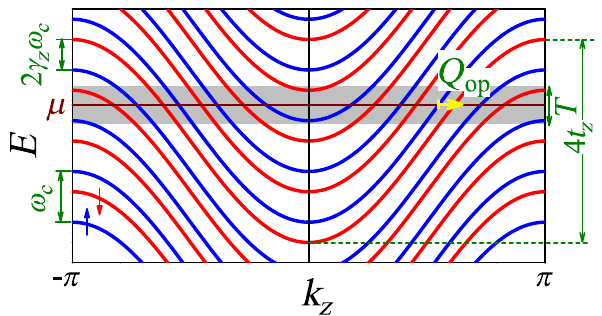
FIG. 2. Illustrative plot of the spin-split Landau-level branches crossing the Fermi level. The plot also shows the relevant energy scales and the optimal modulation wave vector Q